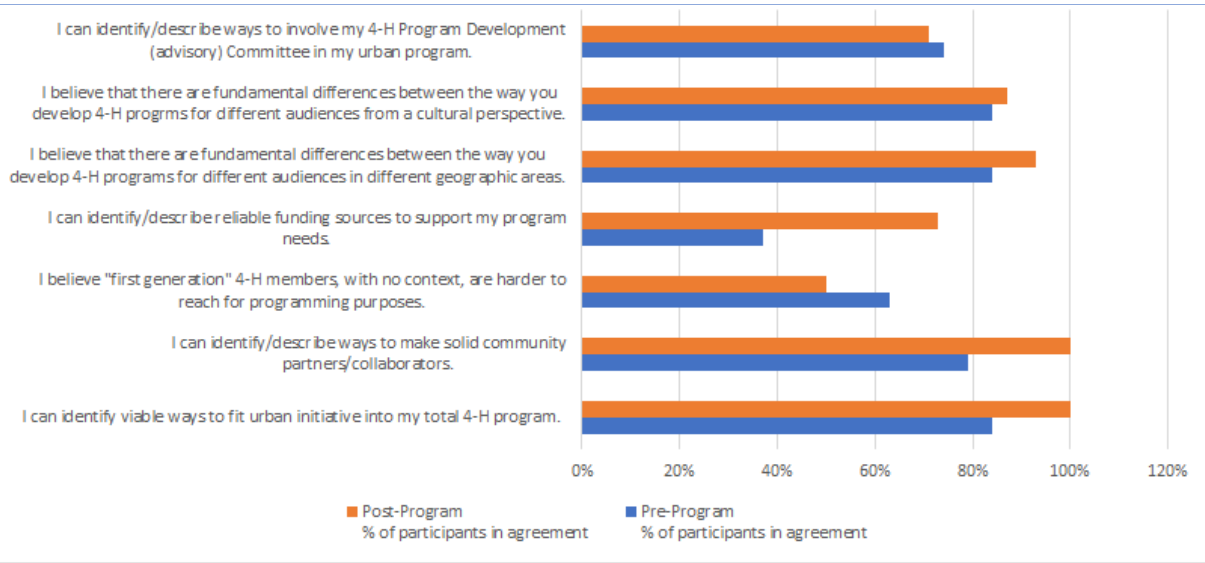
Figure 1. Analysis of Pre- and Post-Tour Urban 4-H Program Development